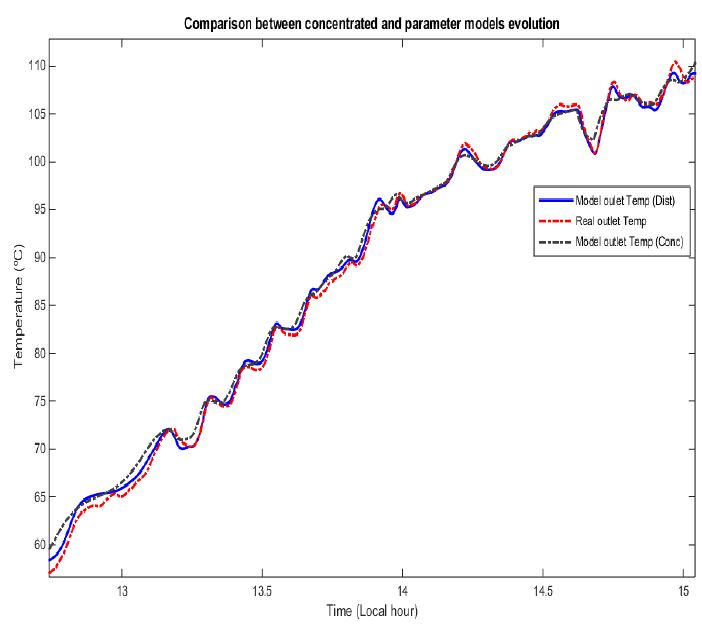
Figure 6. Comparison between distributed (solid blue) and concentrated parameter (dashed-dot black) models: 31 July